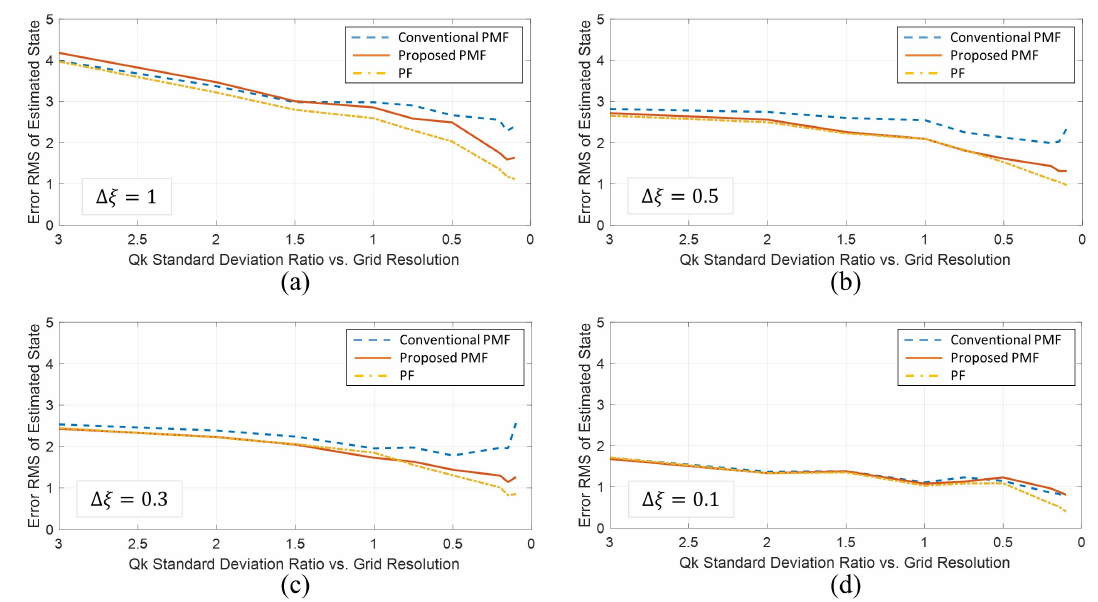
Figure 4. Comparison of the estimation errors between the conventional PMF, the proposed PMF, and the PF for various grid intervals and process noise variances ( a ) ∆ ξ = 1 ( b ) ∆ ξ = 0.5 ( c ) ∆ ξ = 0.3 ( d ) ∆ ξ = 0.1.